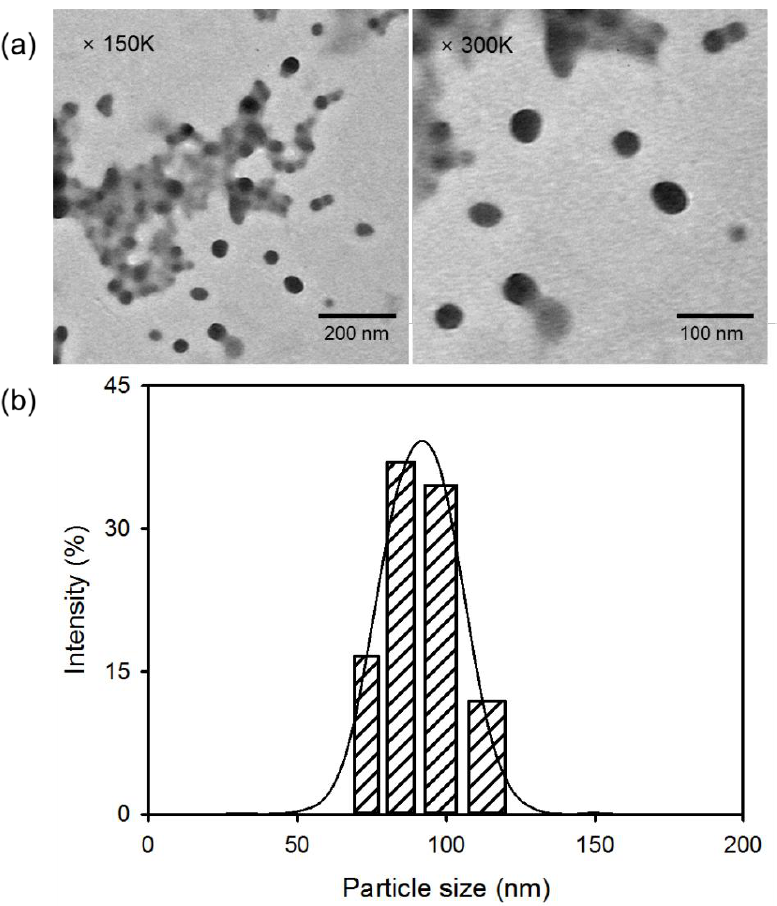
Figure 2. ( a ) TEM images and ( b ) particle size distribution of DC.